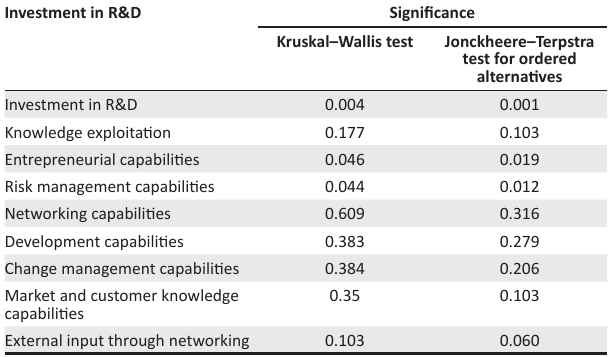
TABLE 4: Kruskal–Wallis test and Jonckheere–Terpstra test for ordered